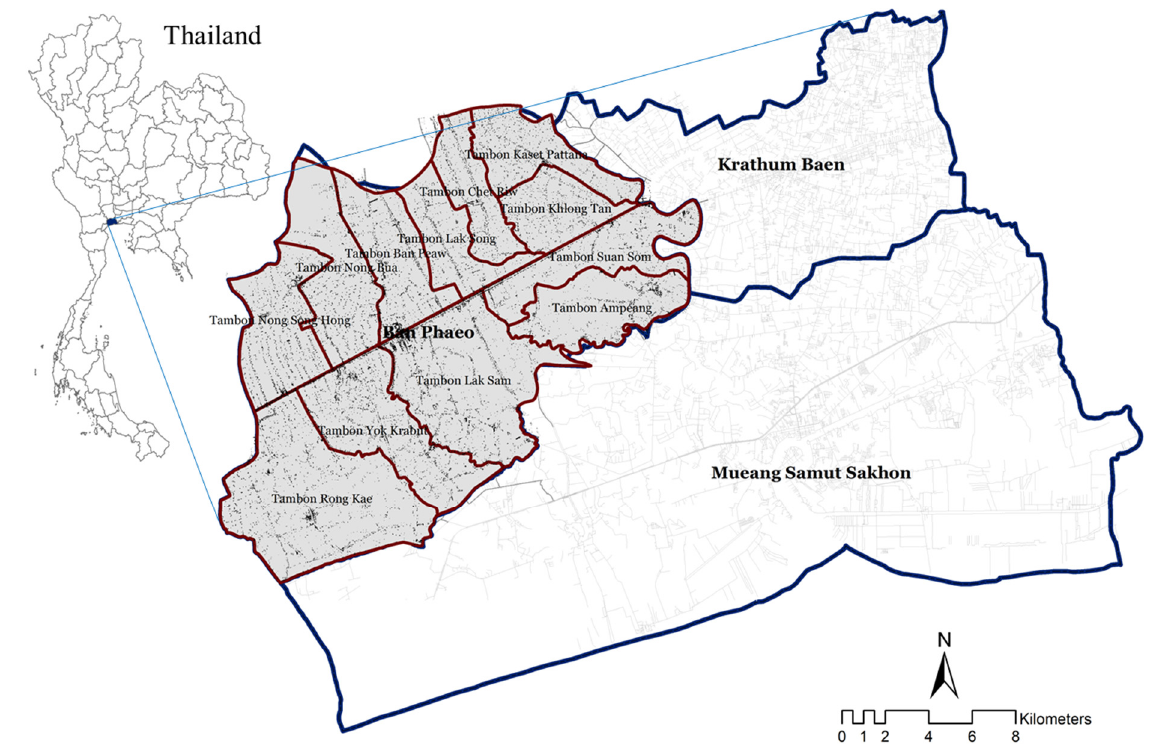
Figure 1. Study area: Ban Phaeo district, Samut Sakhon province, Thailand .